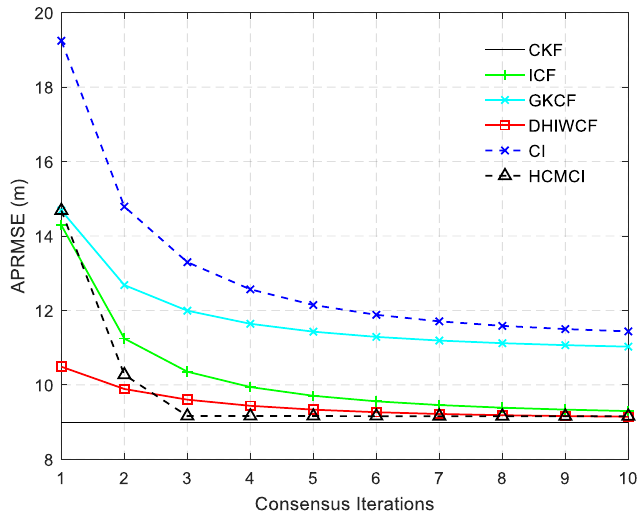
Figure 4. The averaged position root mean squared error (APRMSE) averaged over all nodes, all time steps and all Monte Carlo runs.